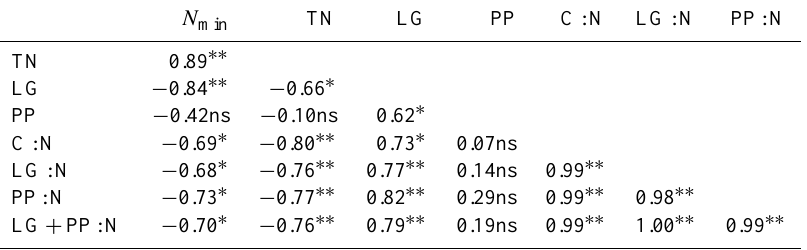
Table 4. Pearson linear correlation coefficients between initial quality characteristics of the plant residues and net N mineralization and correlation within plant-quality